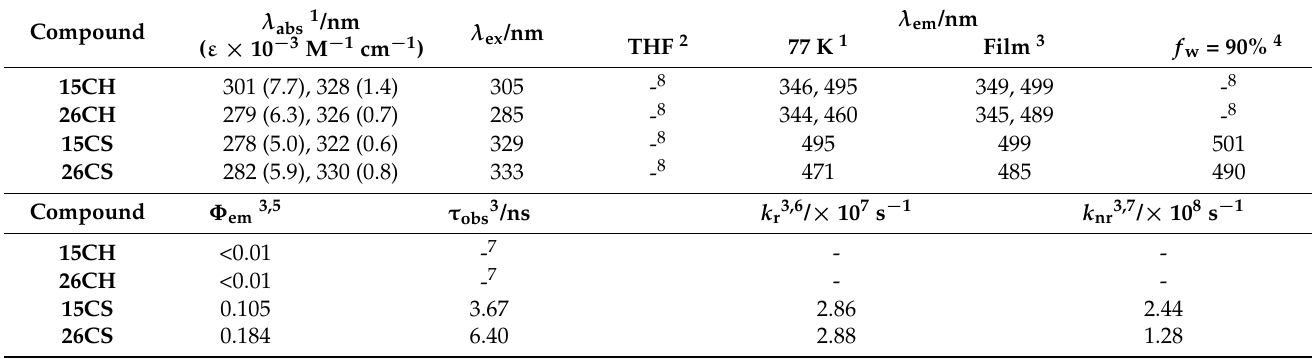
Table 2. Photophysical data for naphthyl-bis- o -carboranyl compounds 15CH , 26CH , 15CS , and 26CS .